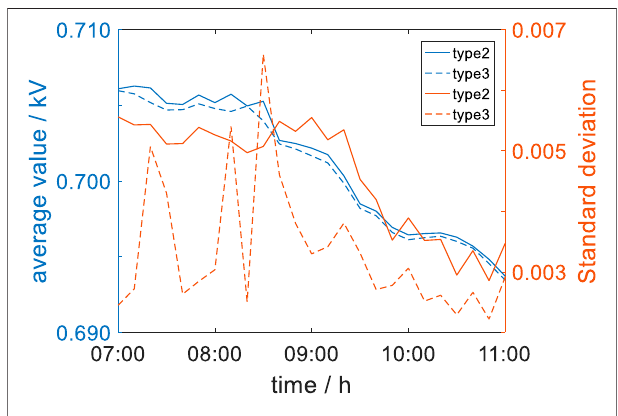
FIGURE 8 | Terminal voltage of WTG.